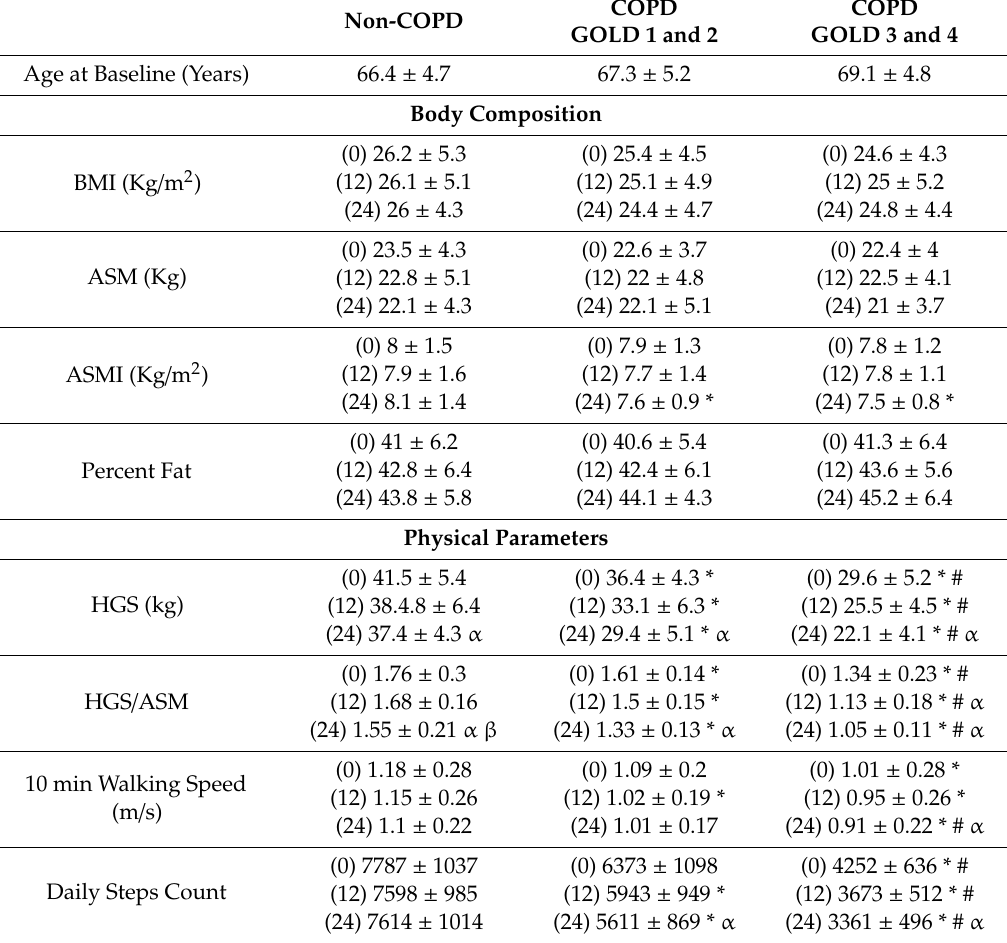
Table 1. Body composition, physical parameters and plasma biomarkers in healthy controls and chronic obstructive pulmonary disease (COPD)